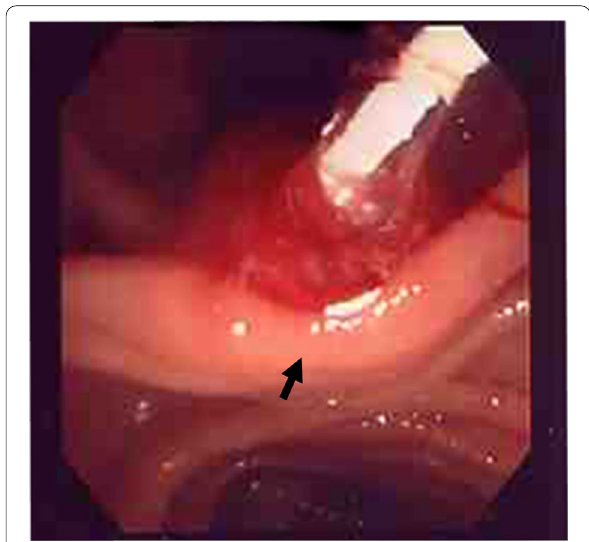
Fig. 2 Endoscopic findings during endoscopic balloon dilatation (EBD). The burst balloon of the endoscopic balloon dilatation (EBD) at the site of the biliary sphincter. Arrow indicates the burst balloon of the EBD catheter at the site of the biliary sphincter